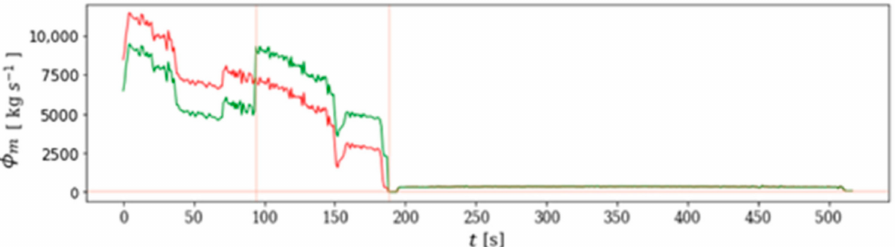
Figure 2. An example of a change in the time dependence of a mass flow φ m . The interval to the right red line, when the rocket discards the main engine, is split into two equal parts (separated by the left red line). In the left part all values are reduced and in the right part increased by λ = 2000 kg / s. The red graph represents φ m in real flight, and green represents φ m in model flight. The areas under the red and green graphs are the same.